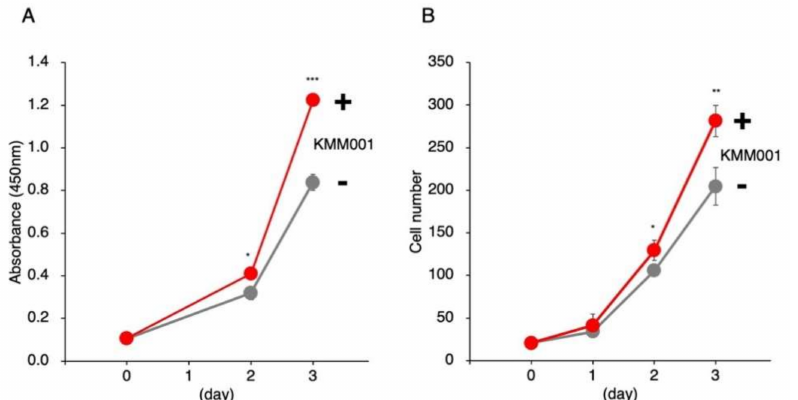
Figure 8. KMM001 enhanced the proliferation of human myoblasts. ( A ). KMM001 was added to the culture medium of immortalized human myoblasts. In a CCK-8 assay, the absorbance increased in treated (red line) and nontreated (gray line) cells. Notably, the absorbance of the cells treated with KMM001 was significantly higher at third day than that of the nontreated cells (146%, p < 0.001). ( B ). Direct cell counting using a fluorescence microscope showed that the numbers of cells increased over time in both the treated (red line) and nontreated (gray line) groups. Notably, the number of KMM001-treated cells was significantly higher than that of nontreated cells at third day (138%, p < 0.01). * = p < 0.05, ** = p < 0.01, *** = p < 0.001 vs. 0